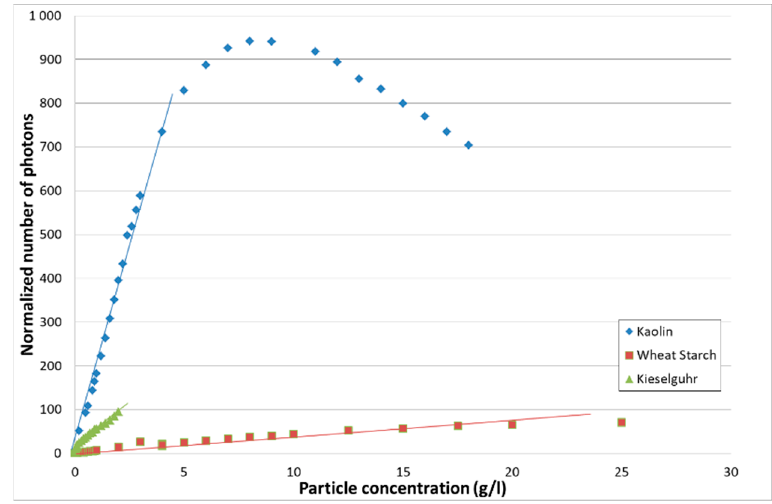
Figure 9. Evolution of the normalized number of photons of TROT as a function of the particle type and concentration.